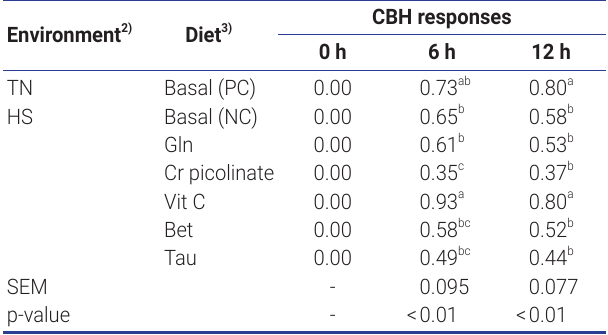
Table 4. Effects of dietary supplementation of various functional nu- trients on cutaneous basophil hypersensitivity responses of broiler chickens raised under heat stress conditions 1)